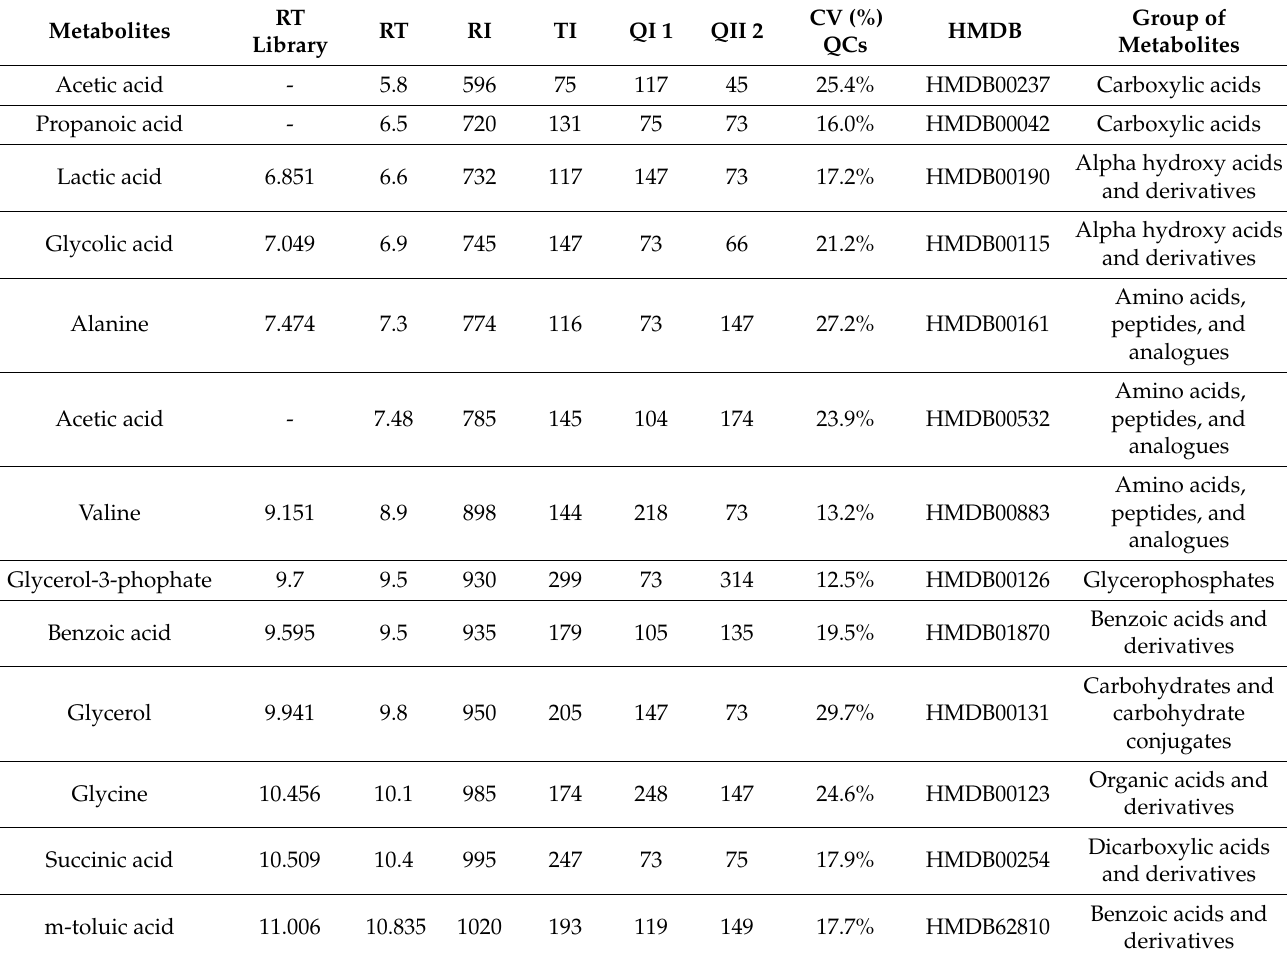
Table 1. List of metabolites included in the statistical